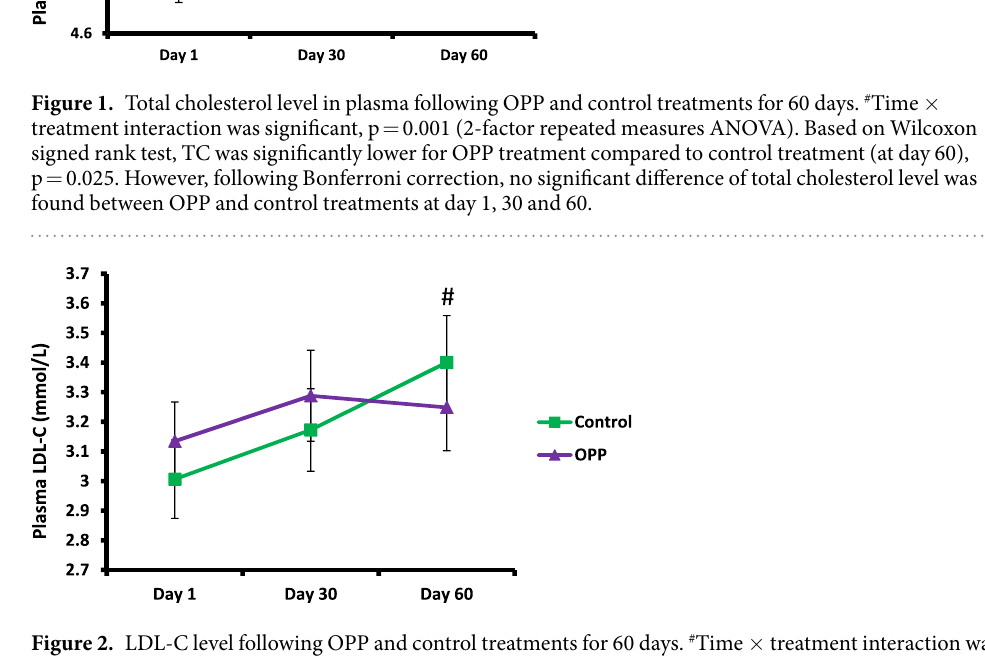
Figure 2. LDL-C level following OPP and control treatments for 60 days. # Time × treatment interaction was significant, p = 0.018 (2-factor repeated measures ANOVA). Based on Wilcoxon signed rank test, LDL-C was significantly lower after OPP compared to control treatment (at day 60), p = 0.04. However, following Bonferroni correction, no significant difference of LDL-C level was found between OPP and control treatments at day 1, 30 and